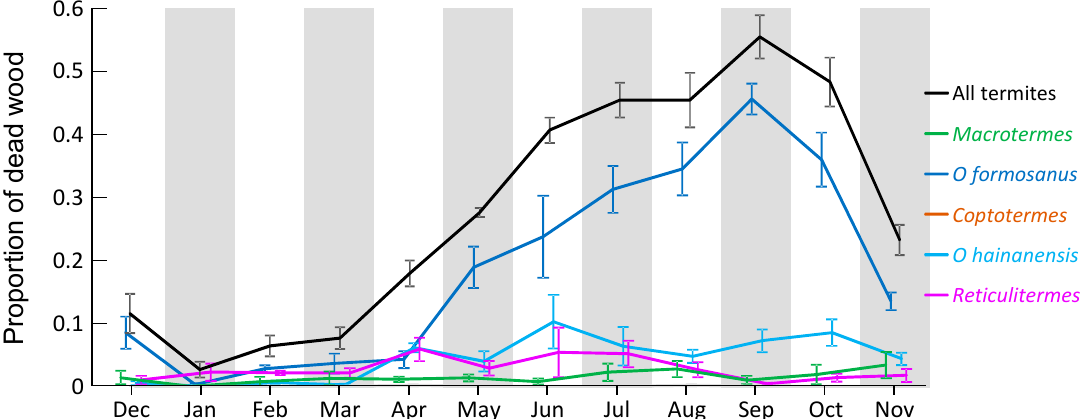
Figure 7. Termite activity over one year in Hangzhou Botanical Gardens, China. Data are average (± standard error) proportion of dead wood on ground containing termites. There were 200 pieces of wood sampled each month.